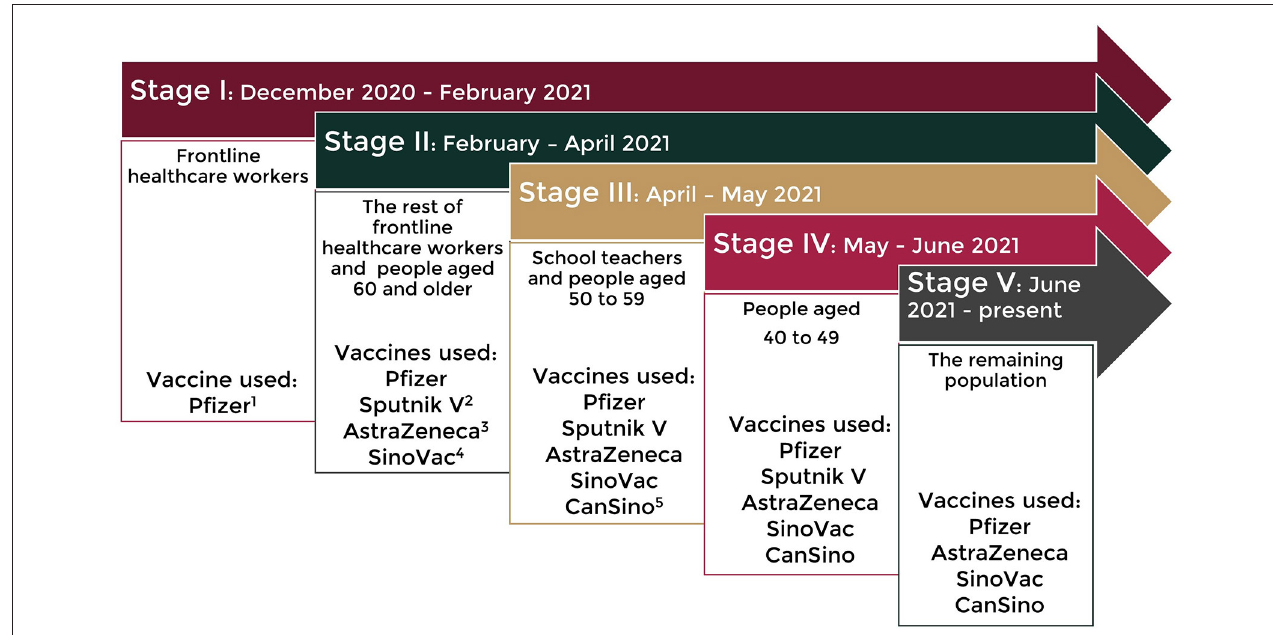
FIGURE 1 | Vaccination strategy in Mexico. 1 BNT162b2 (Pfizer-BioNTech), 2 Gam-COVID-Vac (Gamaleya’s Sputnik V), 3 ChAdOx1 (AstraZeneca), 4 CoronaVac (Sinovac Life Sciences), and 5 Ad5-nCoV